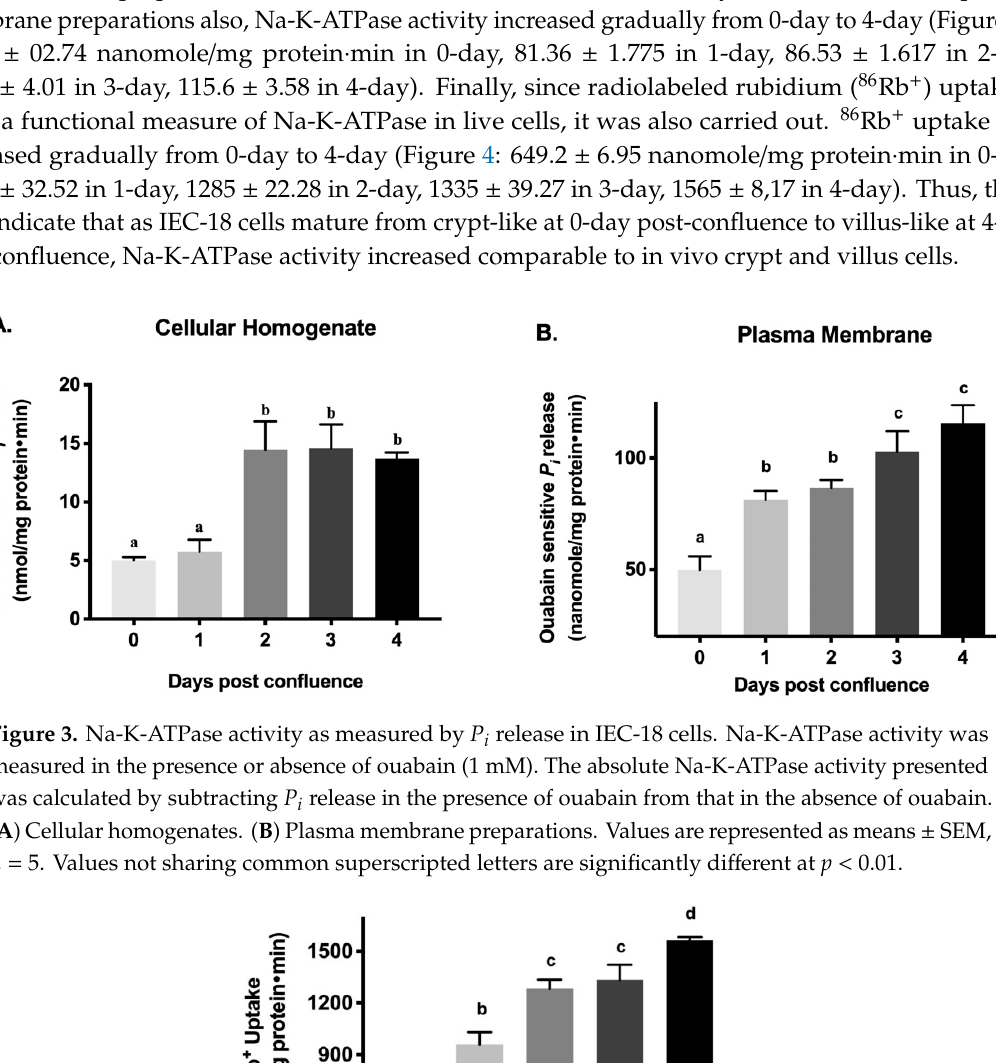
confluence (Figure 3A: 5.01 ± 0.12 nanomole/mg protein•min in 0-day, 5.74 ± 0.47 in 1-day, 14.48 ±